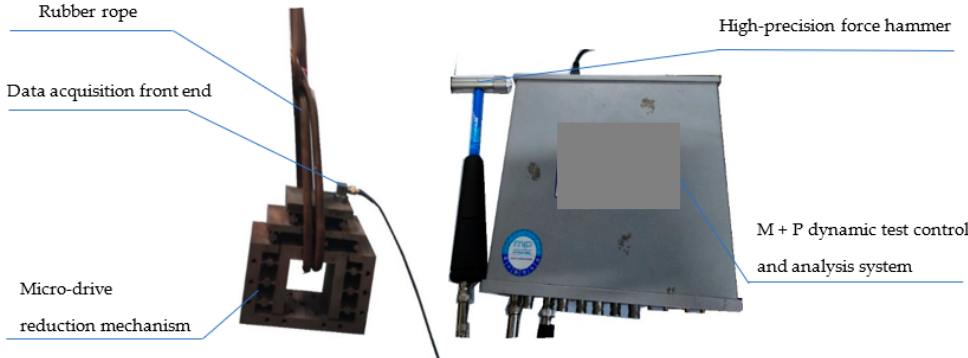
Figure 14. Diagram of the experimental dynamic performance of the micro-drive reduction mecha- nism.